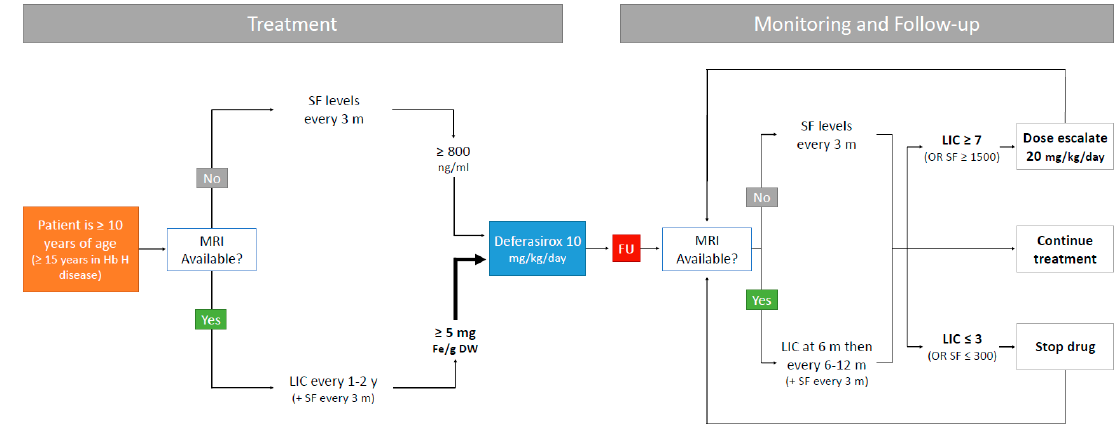
Figure 2. Iron overload screening, diagnosis and treatment algorithms in non-transfusion-dependent thalassemia [1,37]. SF: serum ferritin; LIC: liver iron concentration in mg Fe/g dry weight; FU: follow-up